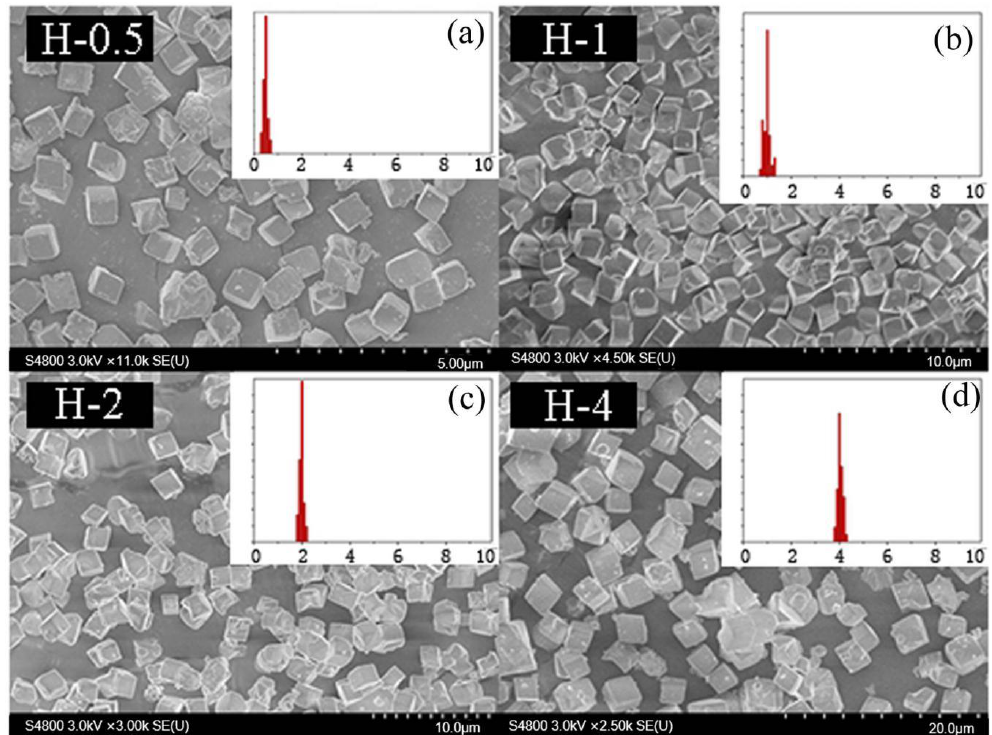
Figure 12. The SEM results of SSZ-13 with di ff erent sizes (Si / Al = 15). ( a ) H-5; ( b ) H-1; ( c ) H-2; ( d ) H-4.